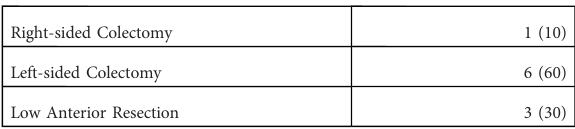
TABLE 2 Operation type.